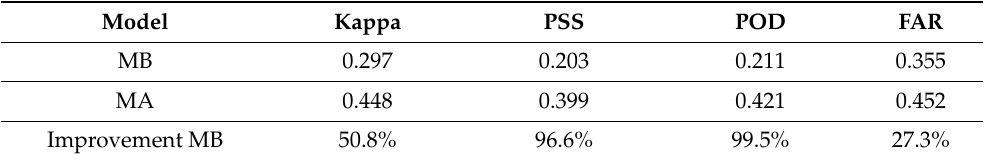
Table 6. Performance comparisons. MB and MA denote the models before and after the hyperparam- eters in GMM-SMOTE and XGBoost are